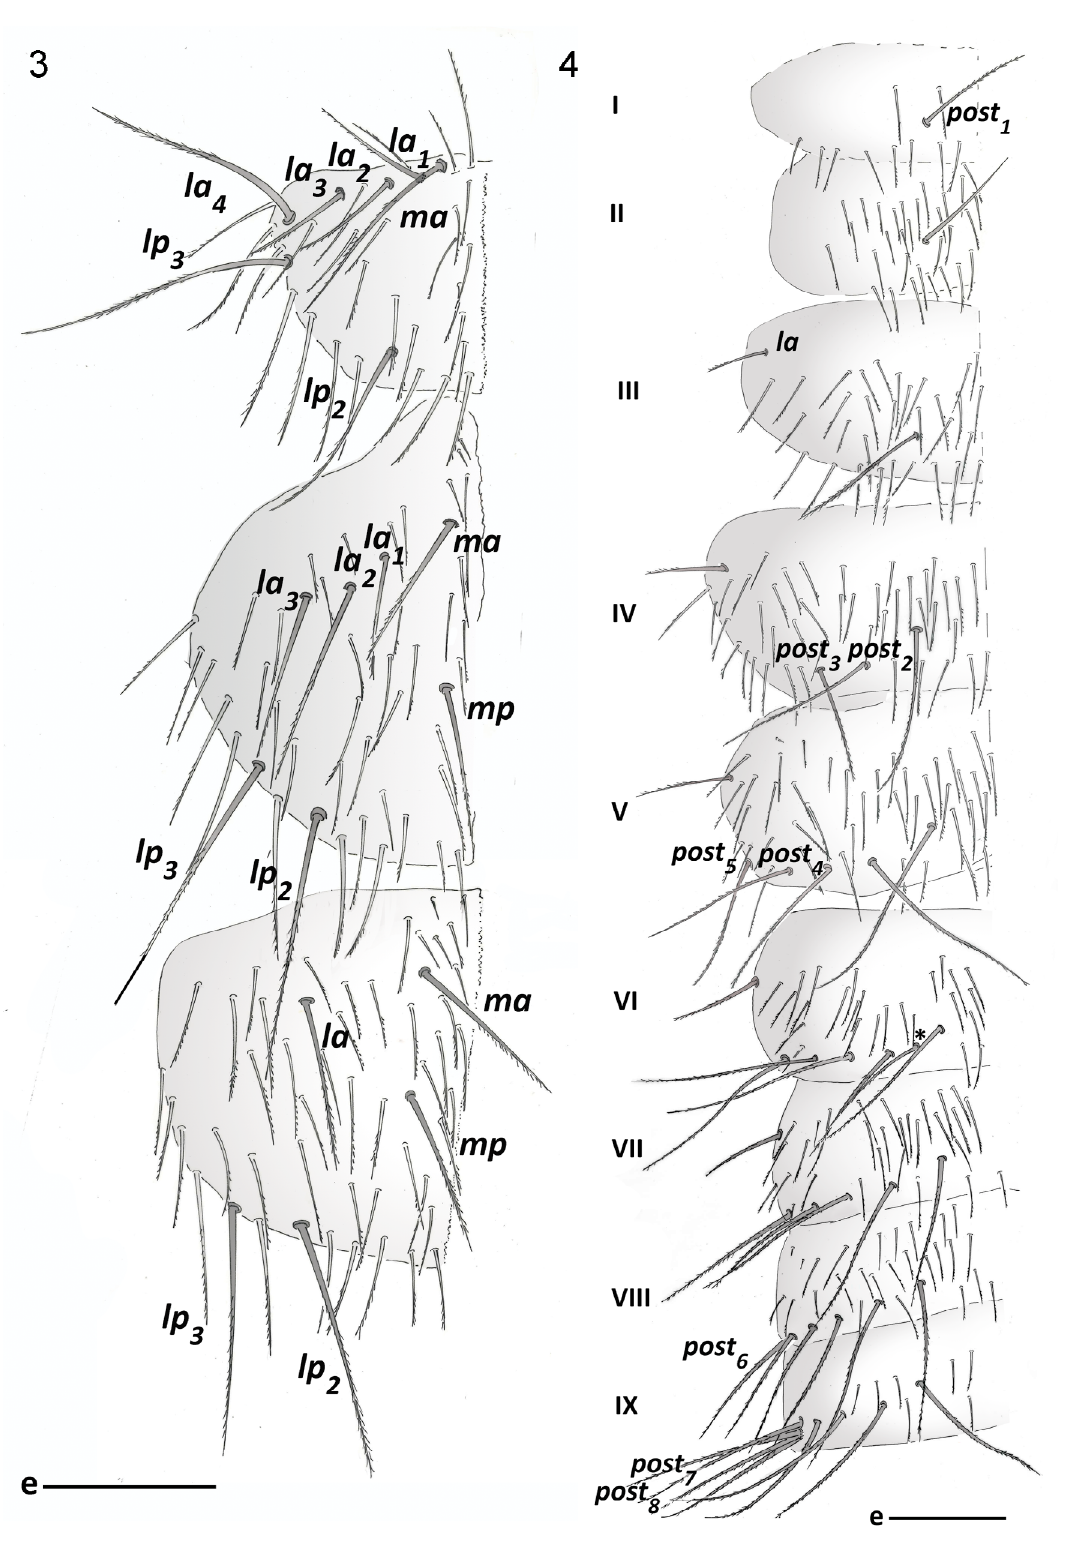
Figs 3–4. Plusiocampa (Pentachaetocampa) inopinata subgen. et sp. nov., holotype, ♀. 3 . Pro-, meso- and metanotum, left side. 4 . Urotergites I–IX, left side. Scale bars = 0.2